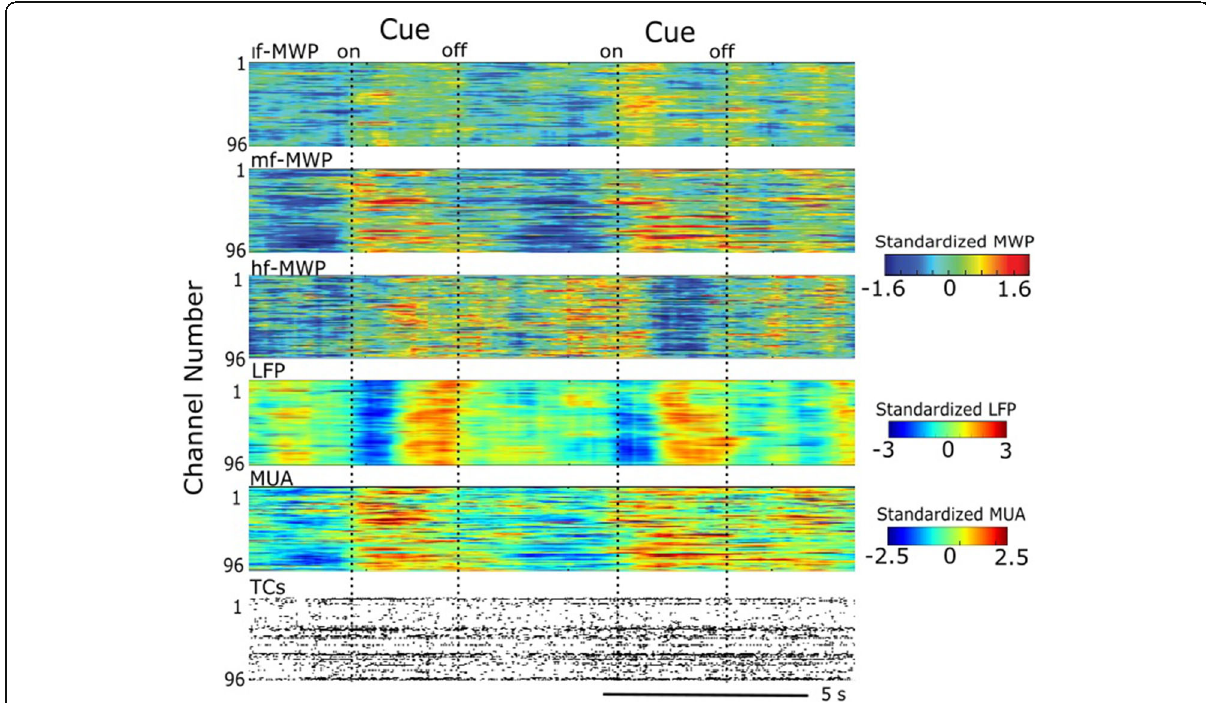
Fig. 4 Brain signal modulated by the presentation of cues during Task 2. A representative snapshot of neural modulation as the participant imagined the cued hand movements during Task 2. Heat maps show lf -MWP, mf -MWP, hf -MWP, LFP and MUA features, and raster plot of TCs from raw recordings, respectively. Each time point is 100 ms. For TCs, each data point represents the total number of detected TCs within 100